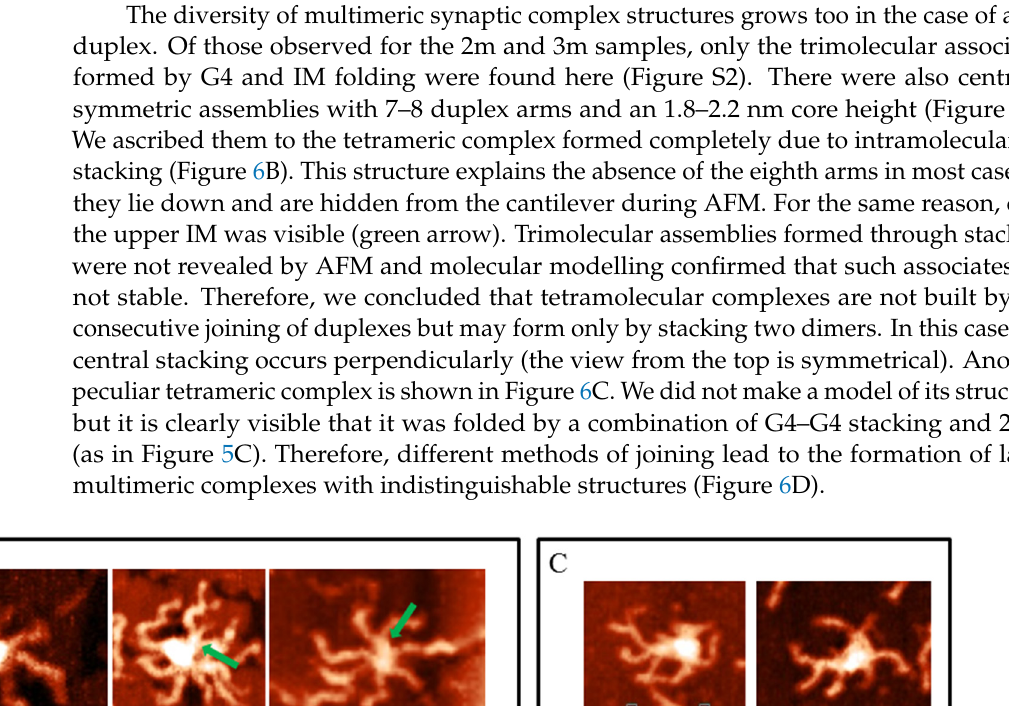
vealed by AFM. Red arrow indicates the free G ‐ rich chain, and green arrow indicates the folded G4 structure. Scale bars: 50 nm. ( E ) Molecular model of duplex joining through stacking of intramo ‐ lecular G4s. ( F ) Examples of the complexes, consistent with model ( E ), revealed by AFM. Green arrows indicate folded IM structures. Scale bars: 50 nm.